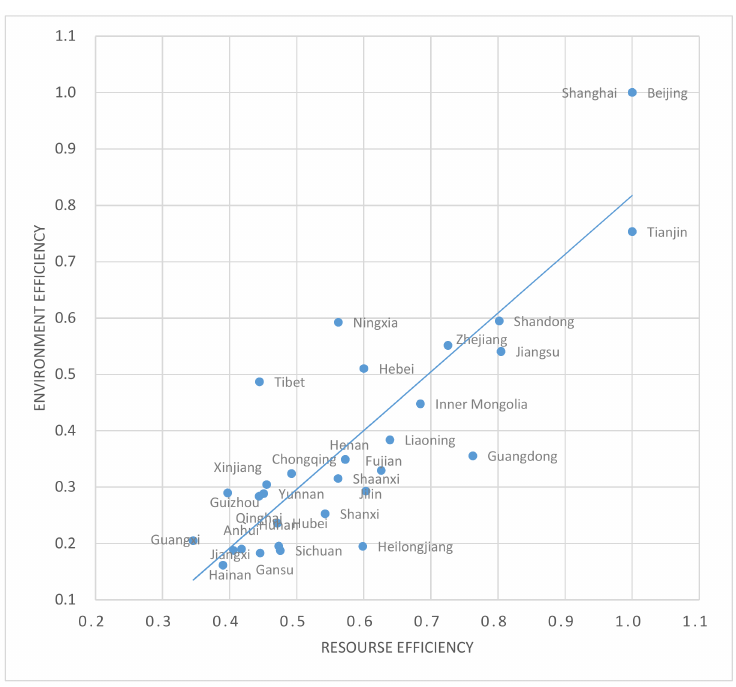
Figure 3. Relationship between environmental efficiency and resource